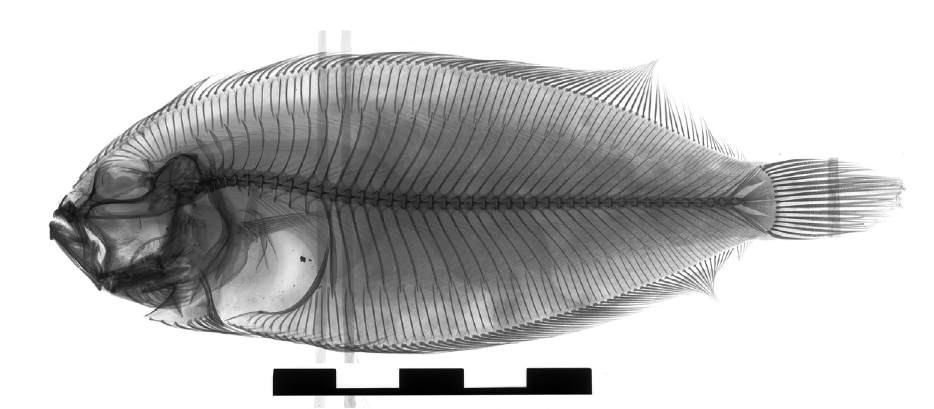
Fig. 9. – Arnoglossus imperialis Rafinesque, 1810, BMNH 1895.7.16.7, one male, 110.8 mm SL, neotype of Rhombus cristatus Lowe, 1839, Madeira. X-ray taken by J. Maclaine.